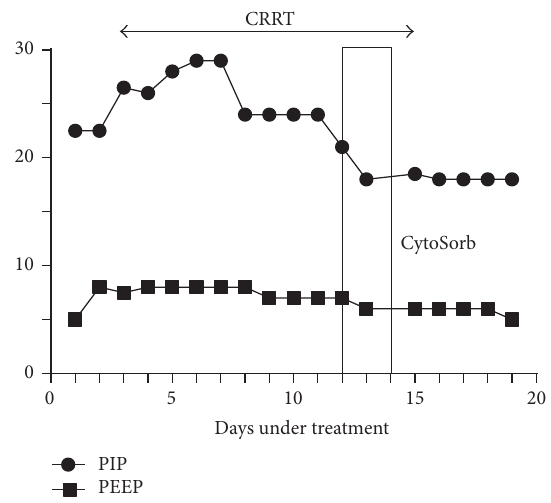
Figure 4: PIP and PEEP settings before, during, and after CytoSorb